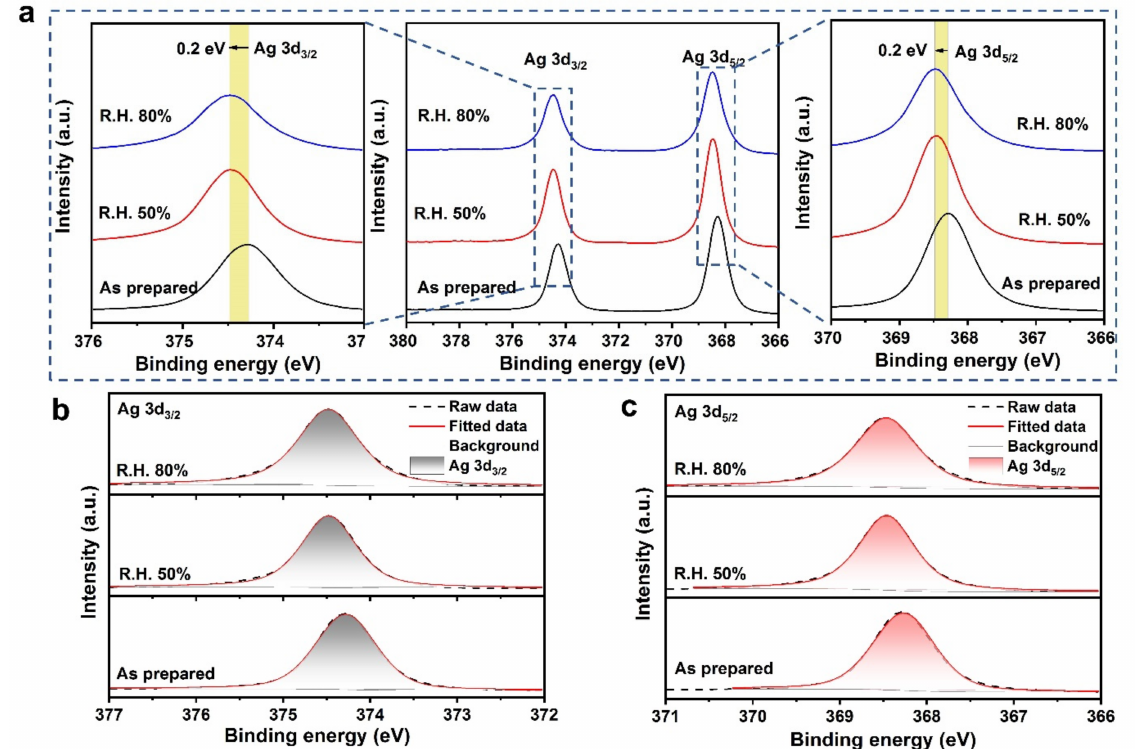
Figure 2. Detailed XPS spectra of Ag 3d photoelectron core level. ( a ) The detailed Ag 3d spectra with and without air exposure; ( b ) The fitted Ag 3d 3/2 spectra with and without air exposure; ( c ) The fitted Ag 3d 5/2 spectra with and without air